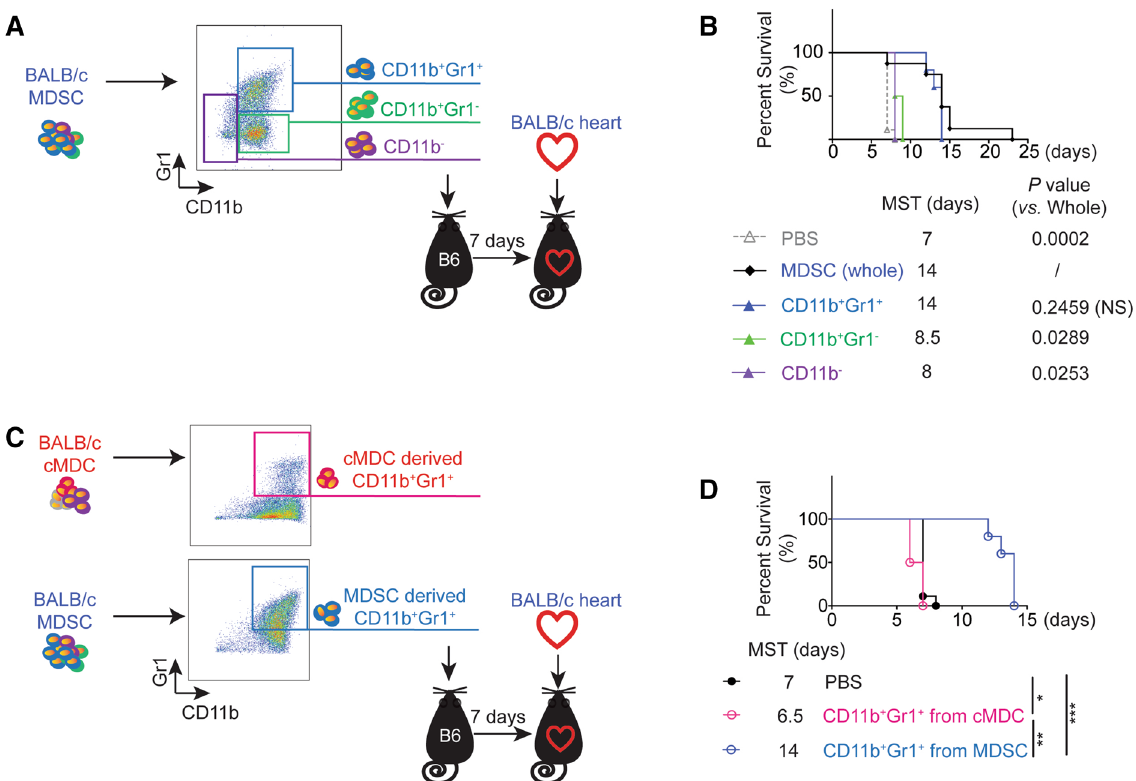
Figure 6. CD11b + Gr1 + population in donor-derived MDSCs is the effective suppressor subset. ( A ) Schematic illustration of the experimental design to study which subset in donor-derived MDSCs impart the immune suppressive function. C57BL/6 recipients received a single-dose intravenous injection of 1 × 10 6 CD11b + Gr1 + or CD11b + Gr1 - or CD11b - cells FACS isolated from BALB/c derived MDSCs 7 days prior to BALB/c derived cardiac graft transplantation. Whole MDSCs infusion and PBS administration groups served as positive and negative control. ( B ) Kaplan–Meier cumulative survival of allograft showing only CD11b + Gr1 + subset rather than CD11b + Gr1 - and CD11b - subsets, reproduces similar allograft prolongation to the whole BALB/c